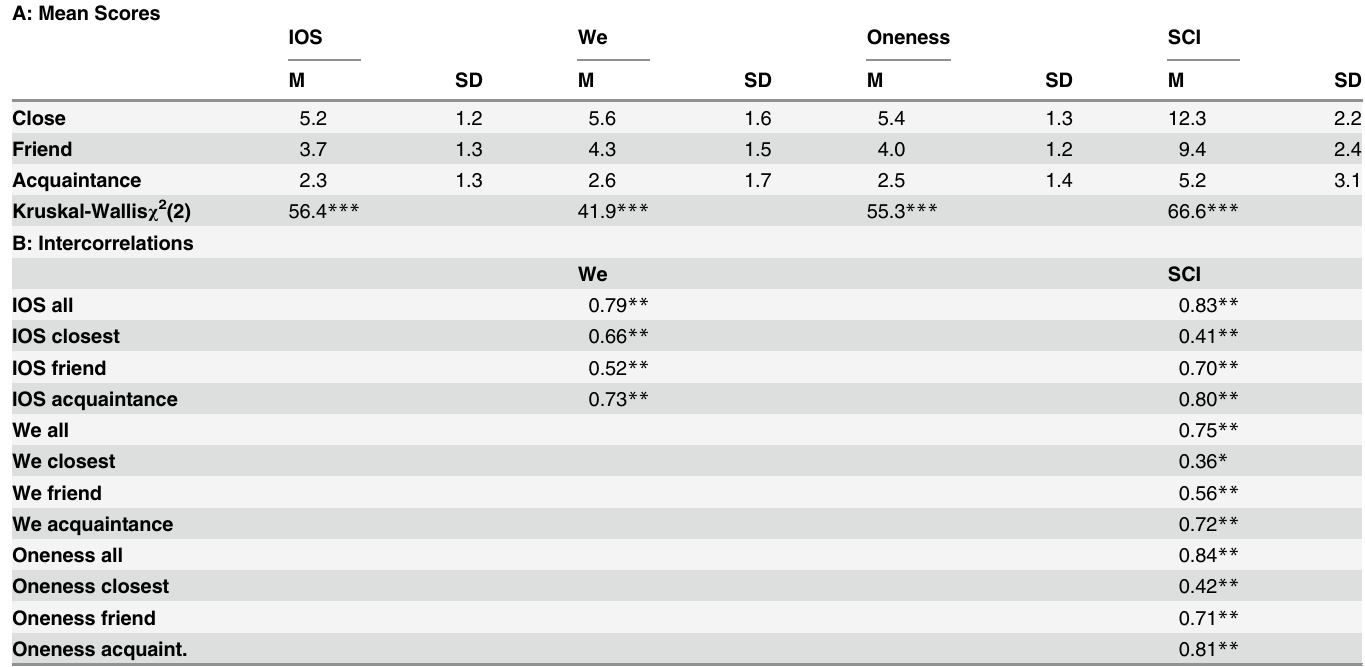
Table 2. Mean scores and intercorrelations of scales in Study